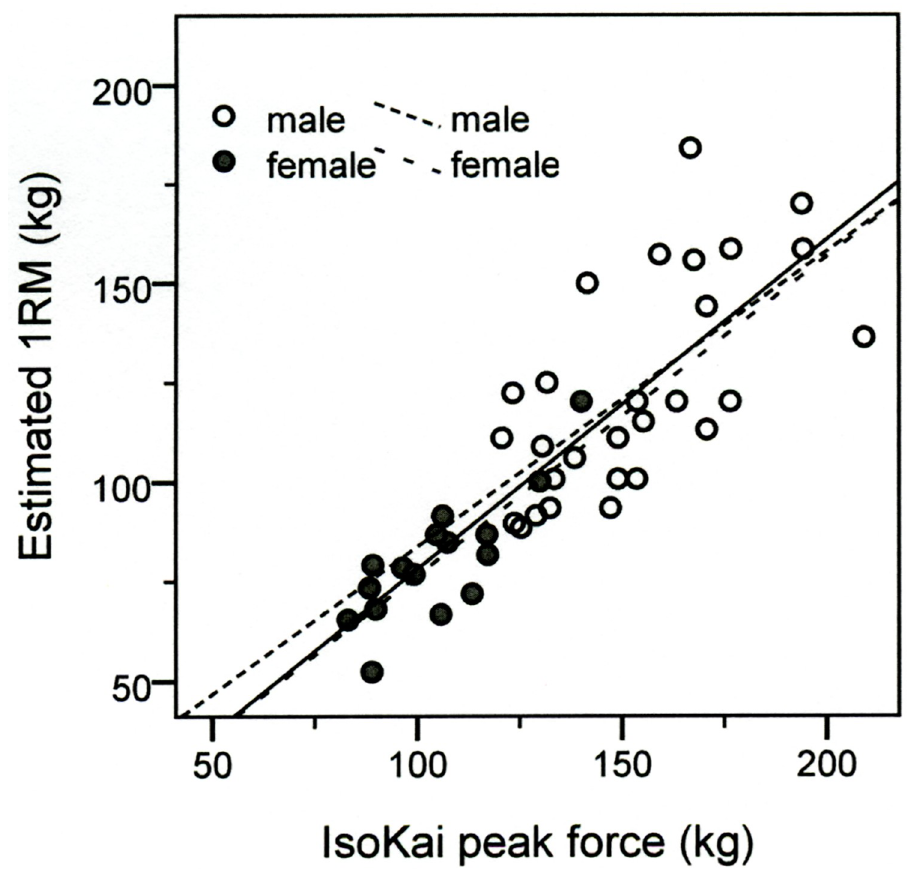
Fig 2. Scatterplot with linear regression lines for the correlation between the IsoKai peak force (IsoKai Peak ) and the estimated 1RM (RM est ) deadlift weights. Black line; total study sample, Hatched black lines; males and females